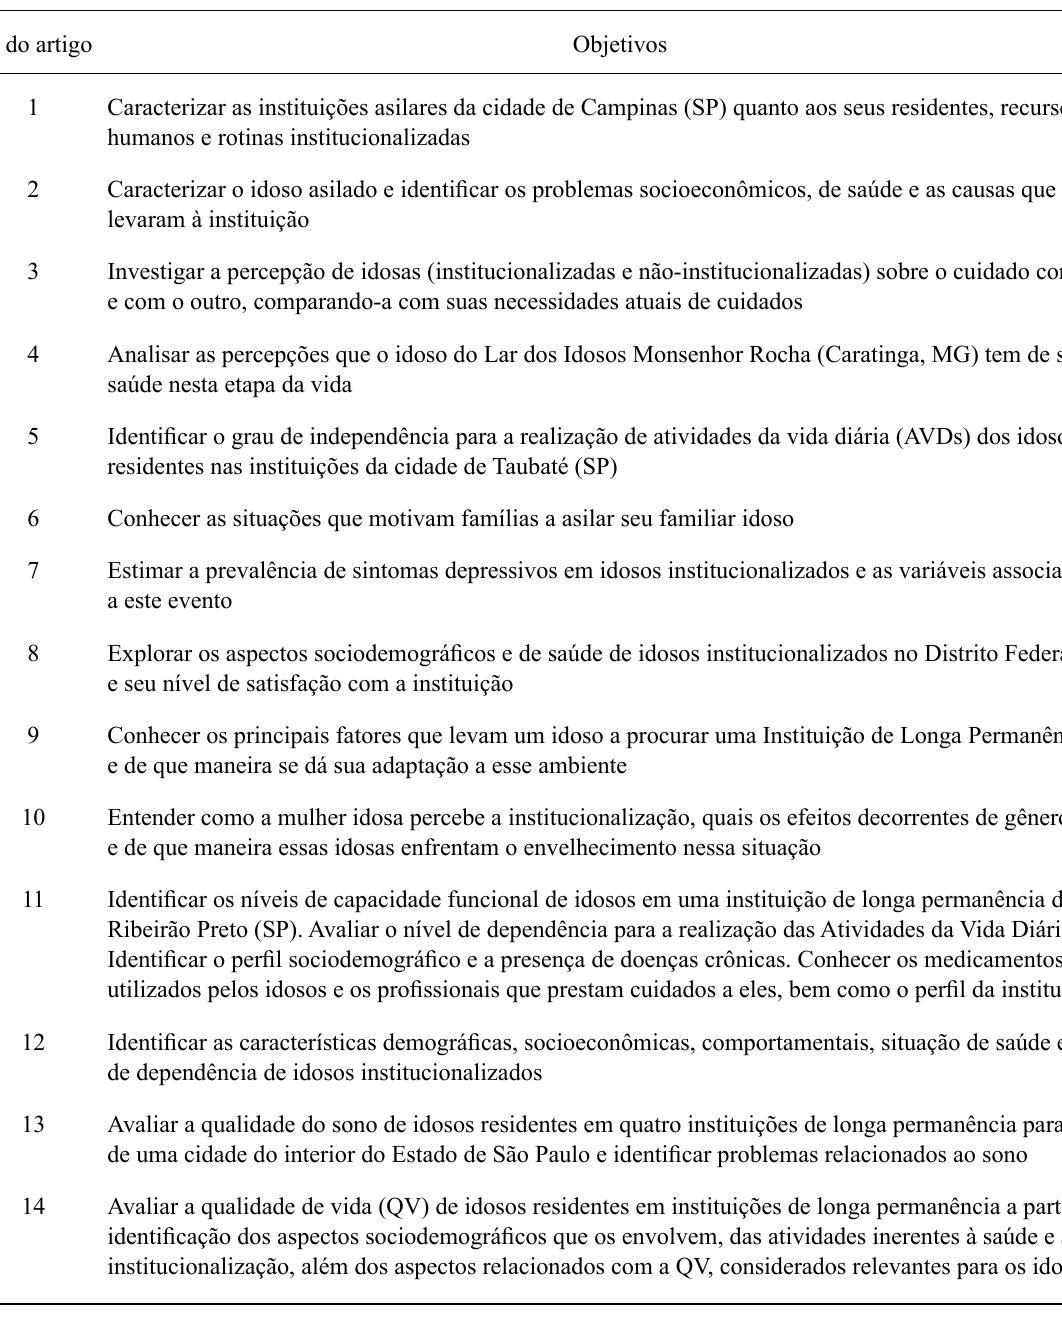
Tabela 2 Objetivos dos Artigos Recuperados